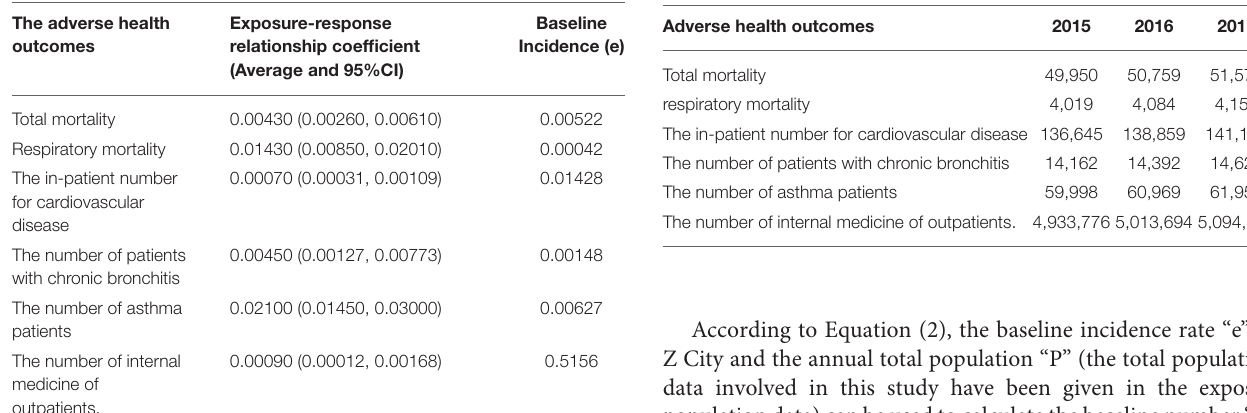
TABLE 5 | Baseline number of each adverse health outcome from 2015 to 2017 [unit: case